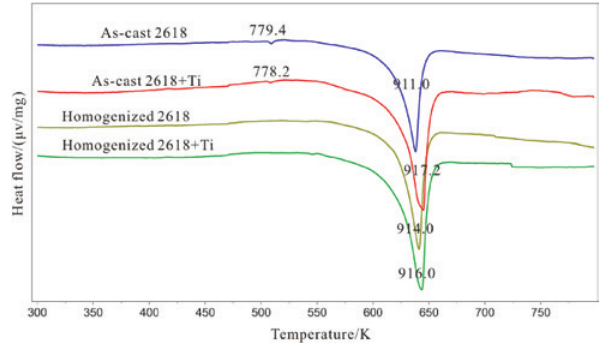
Fig. 4: DTA curves of the as cast and homogenized